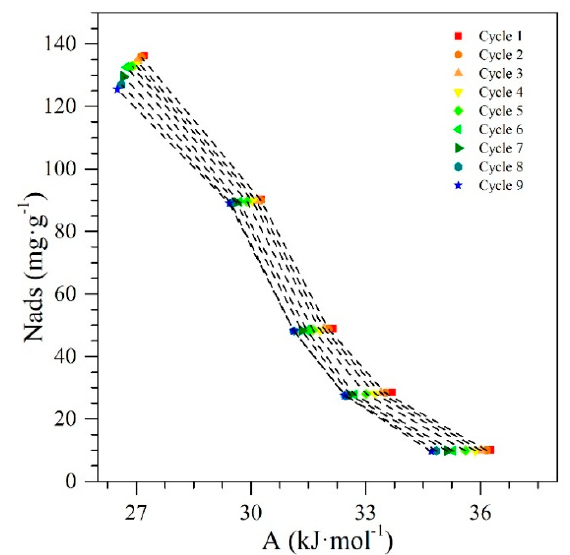
Figure 3. Polanyi’s adsorption potential ( A ) as a function of the amoun adsorbed ( N ads ) for n -C 7 asphaltene adsorption on CeNi0.89Pd1.1 nanoparticles through several catalyst regenerations of adsorption and subsequent catalytic steam gasification.